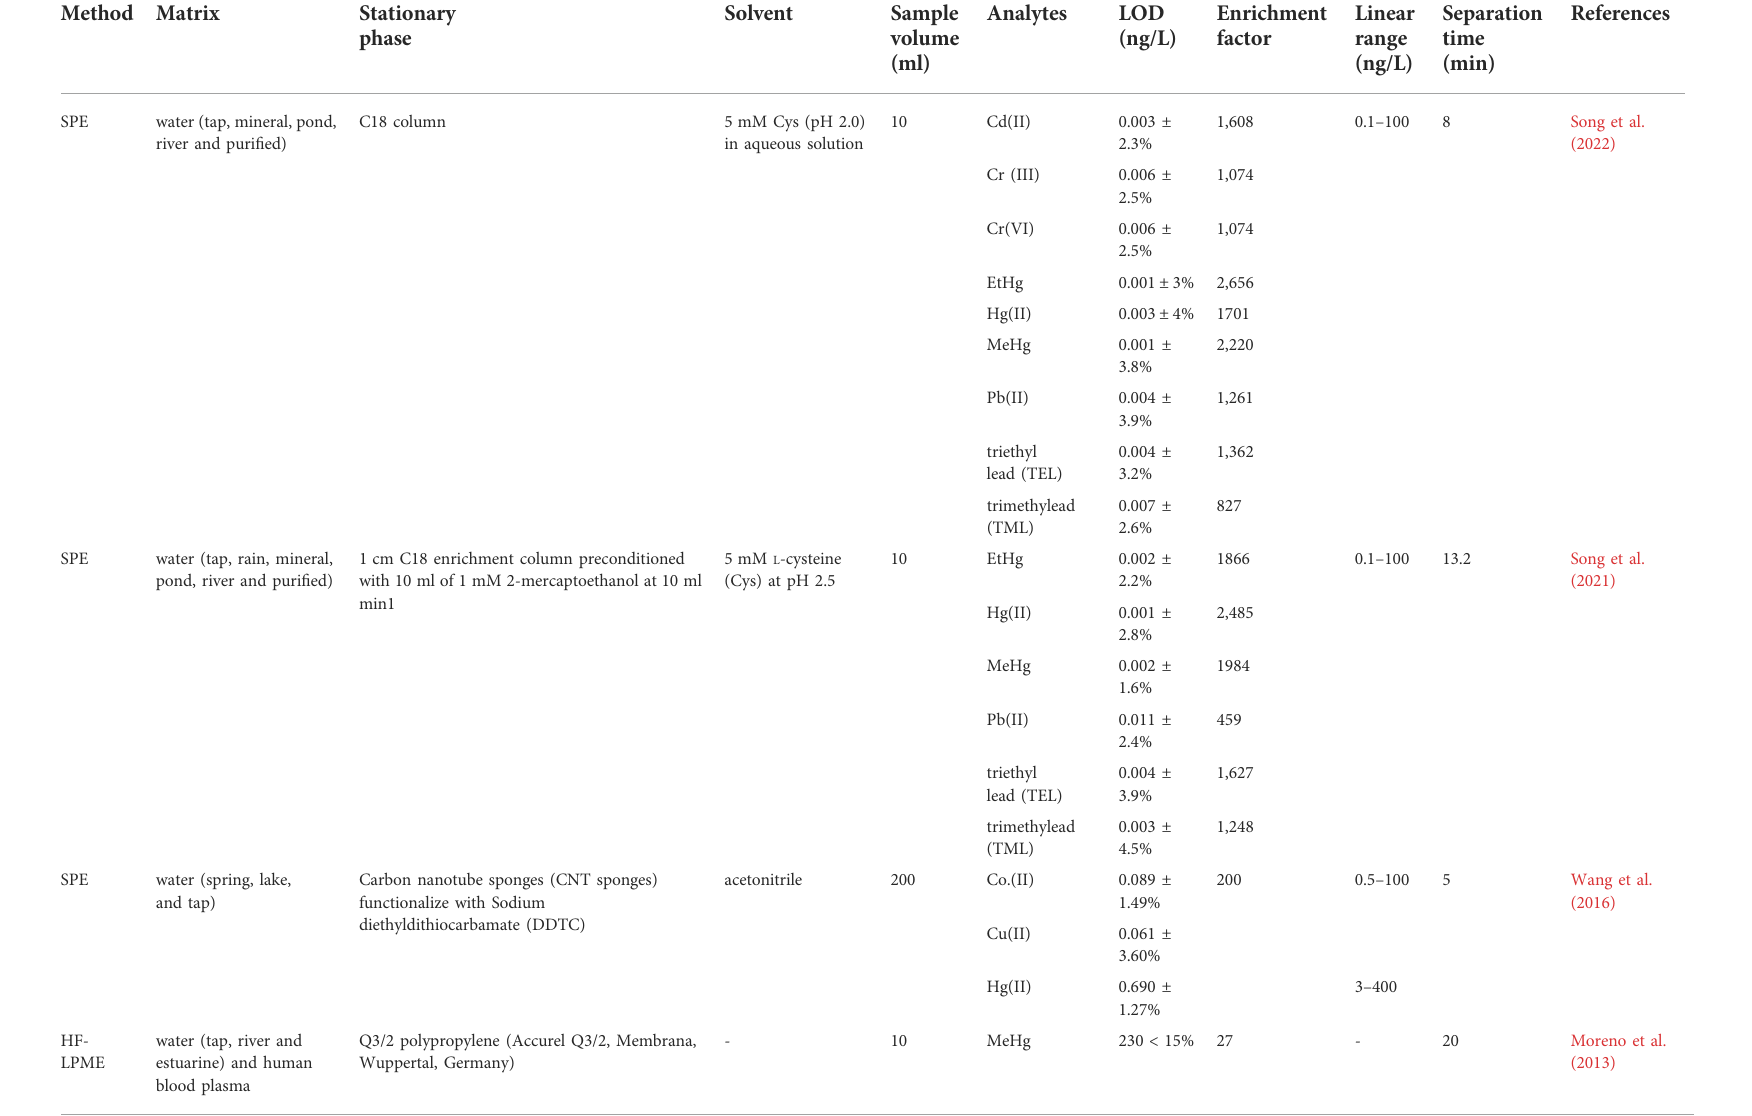
SPE, solid-phase extraction; HF-LPME , hollow fi ber membrane extraction